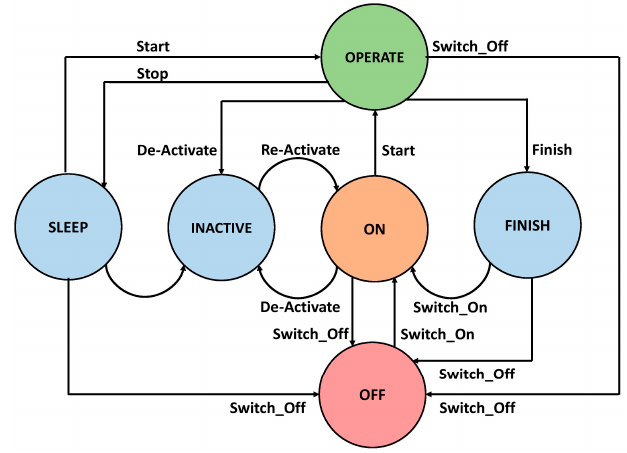
Figure 5. State chart diagram for domestic appliance scheduling.